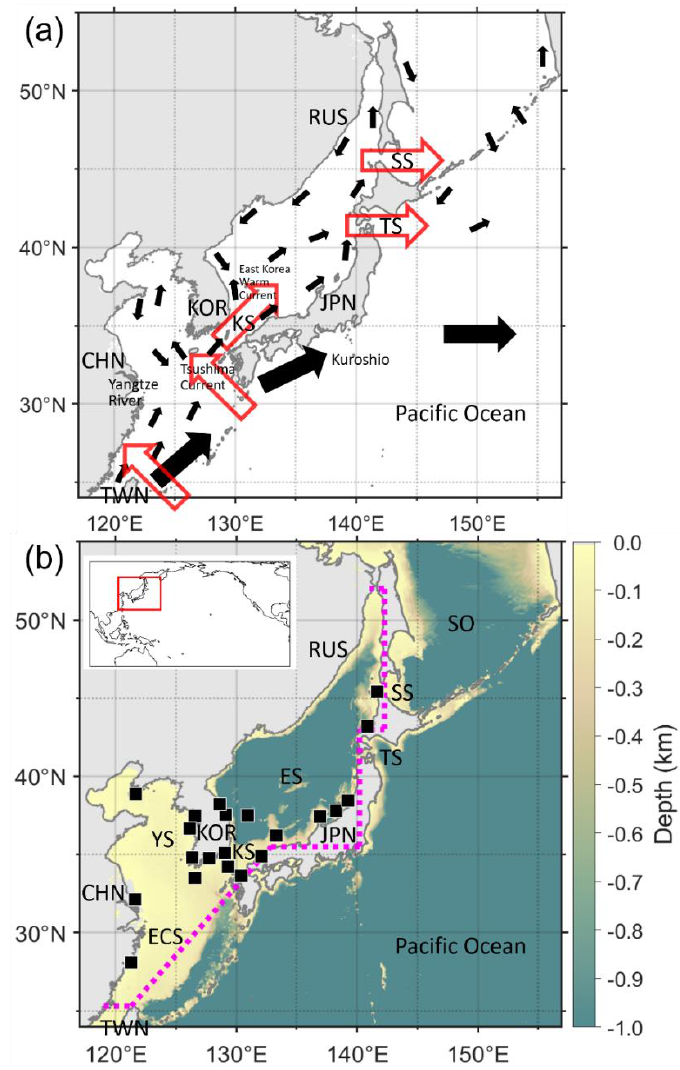
Figure 1. ( a ) Schematics of the regional circulation patterns with major surfaces currents in the northeast Asian marginal seas (NEAMS). The stronger Kuroshio is shown with thicker arrows while other currents are indicated by black filled arrows, respectively. Red open arrows represent major inflow and outflow volume transports. ( b ) Domain (area indicated with magenta dotted lines) and location (red box in the world map in the upper left corner) of the NEAMS, local bathymetry (colors), and locations of tide gauge stations selected for this study (black squares, available at https://www.psmsl.org). KOR, RUS, CHN, TWN, and JPN are the abbreviations for Korea, Russia, China, Taiwan, and Japan, respectively. YS, ECS, ES, and SO indicate the Yellow Sea, East China Sea, East Sea (Sea of Japan), and Sea of Okhotsk, respectively. KS, TS, and SS represent the Korea/Tsushima Strait, Tsugaru Strait, and Soya Strait, respectively.